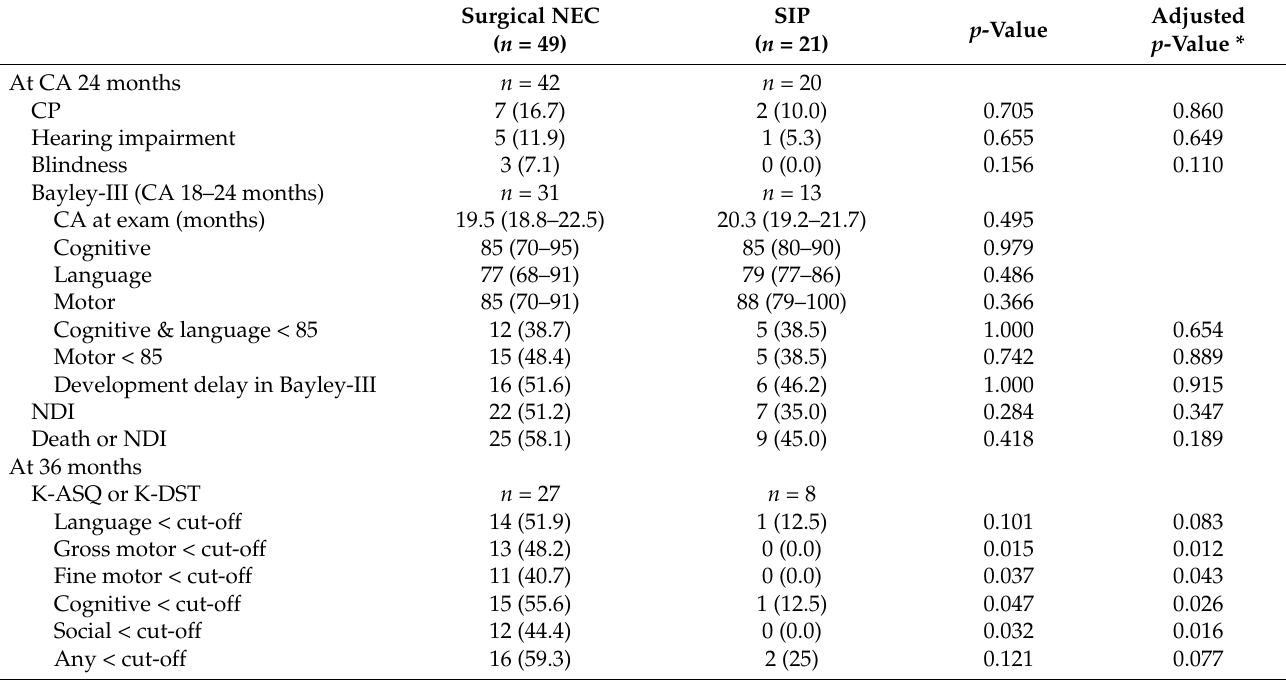
Table 4. Neurodevelopmental outcomes of the study population at corrected age 24 months and 36